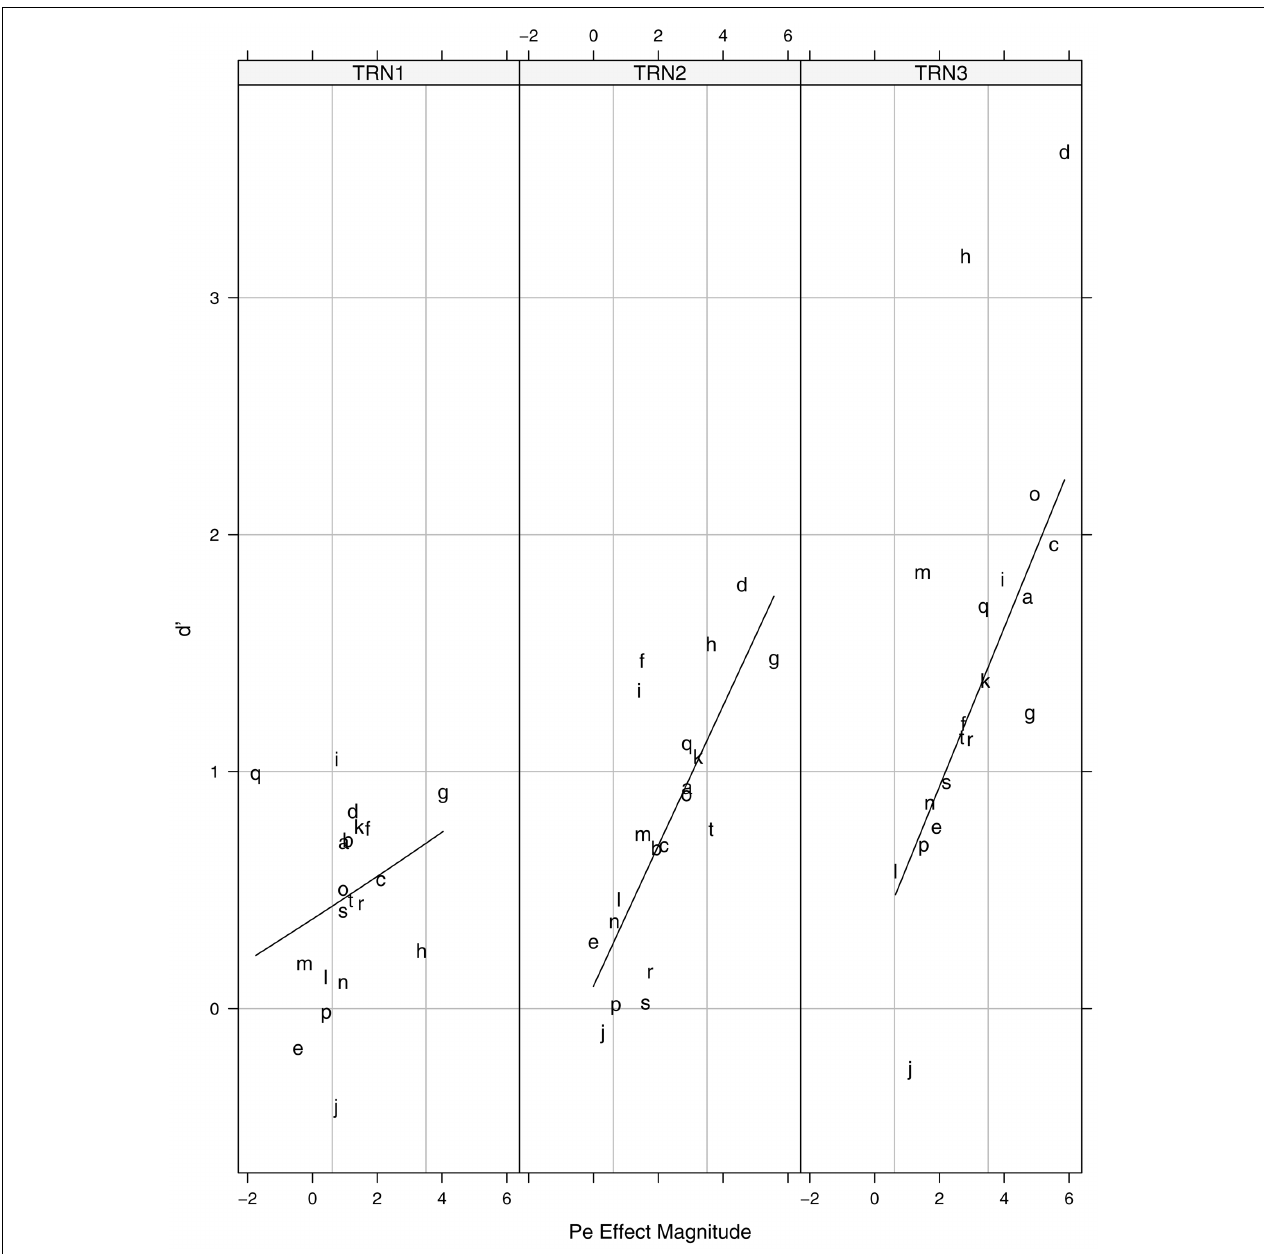
FIGURE 9 | Relationship between feedback- P e and discrimination performance duringTraining blocks 1–3 (subjects indicated by